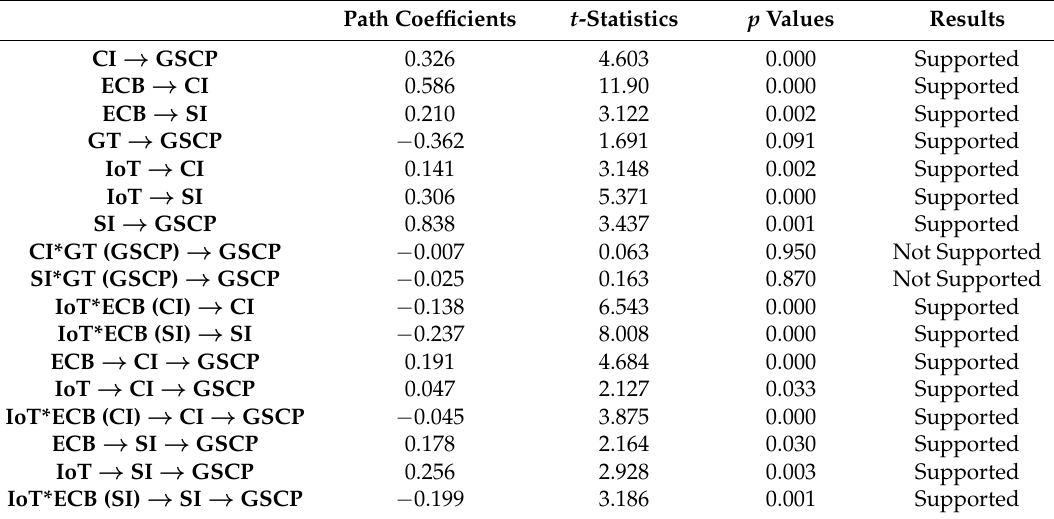
Figure 5. Path coefficients of research variables. Table 4. Research model